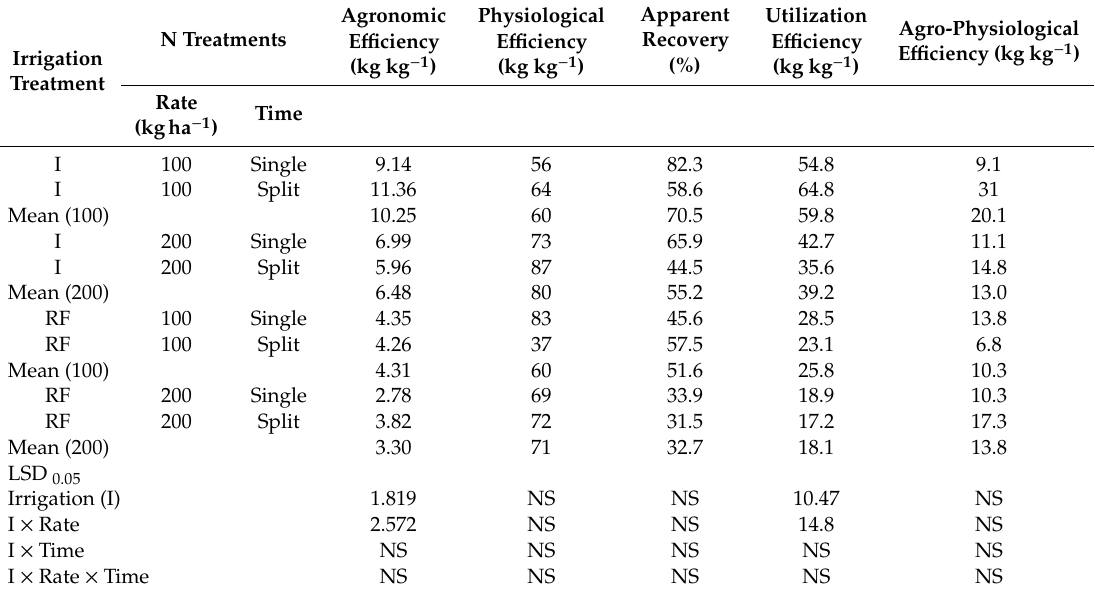
Table 8. E ff ect of irrigation and di ff erent N applications on agronomic e ffi ciency, physiological e ffi ciency, apparent recovery, utilization e ffi ciency and agro-physiological e ffi ciency of canola under irrigated and rainfed conditions at Roseworthy (see definitions and equations in Section 2.4).